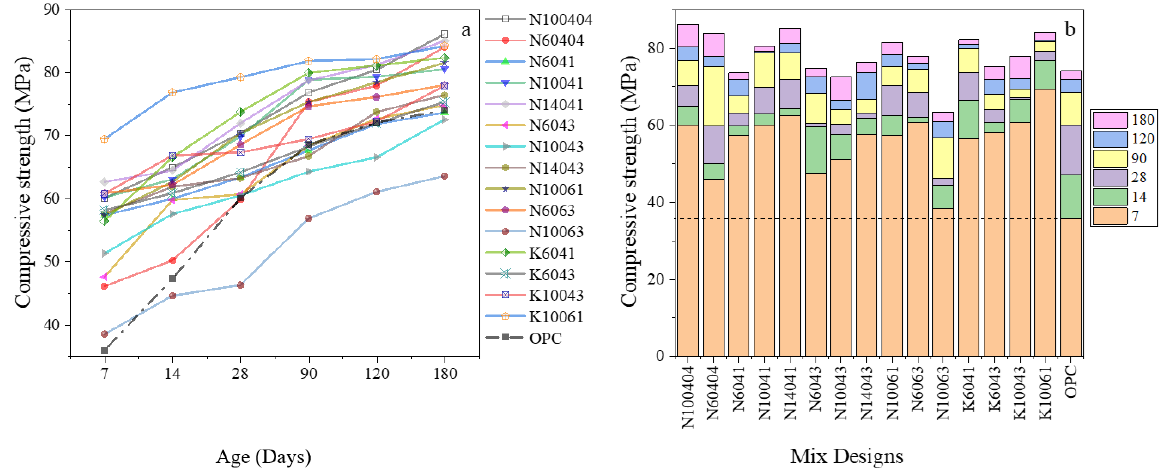
Figure 1. ( a ) Compressive strength development; ( b ) Compressive strength obtained at different ages of OPC and AASC samples before acid exposure. of OPC and AASC samples before acid